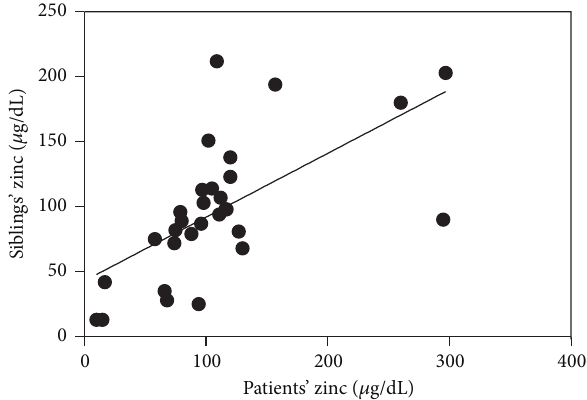
Figure 2: Correlation between patients’ serum Zn values. Levels correlated positively with corresponding ( 𝑟 = 0.635 , 𝑃 < 0.001